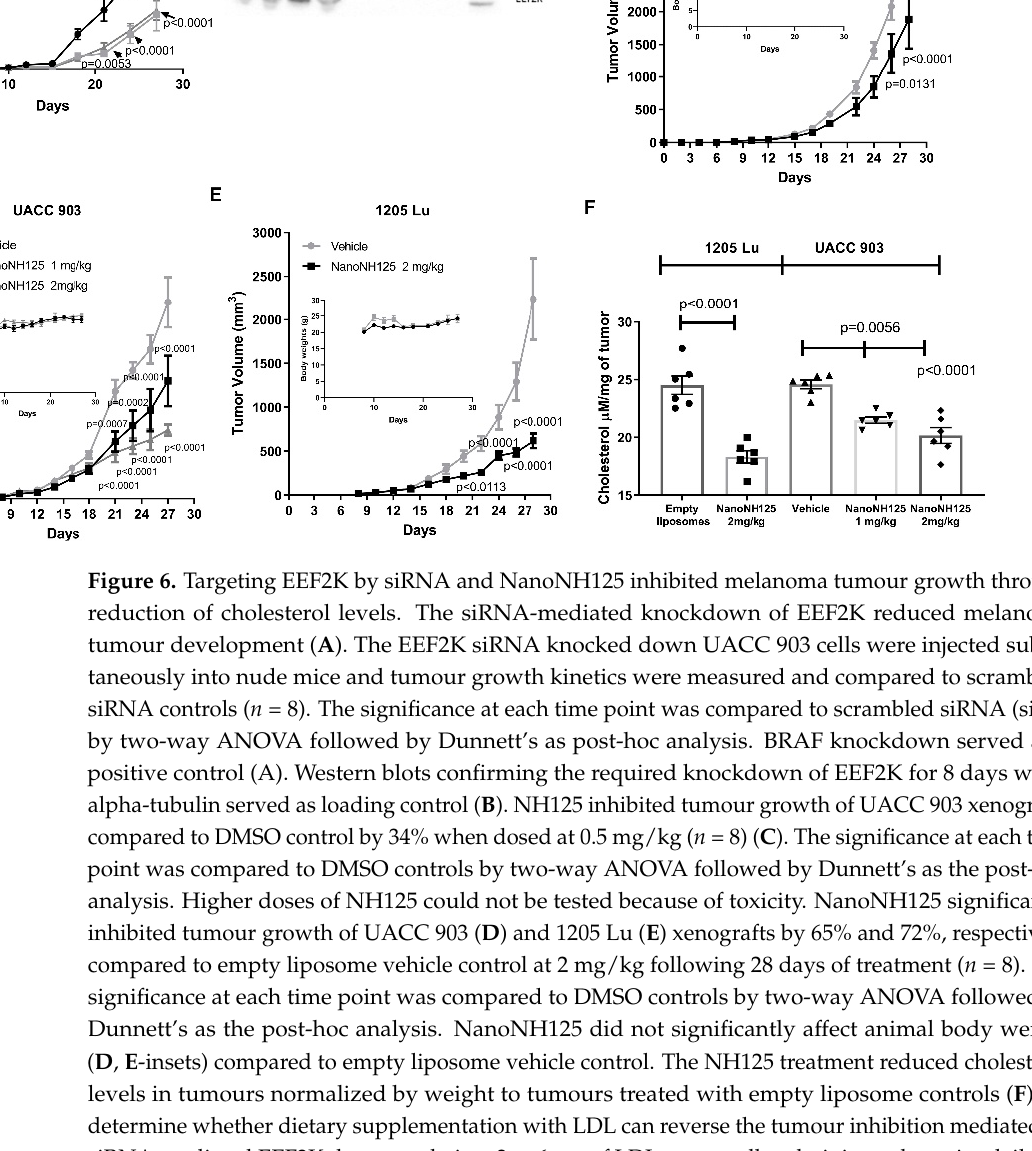
to be subtle as these types of studies in animals are notoriously difficult to achieve. Since the reversal of the siEEF2K effect on tumour development was subtle, it may be due to insufficient pre-treatment or an inappropriate delivery route to achieve the optimal cholesterol levels needed for a full